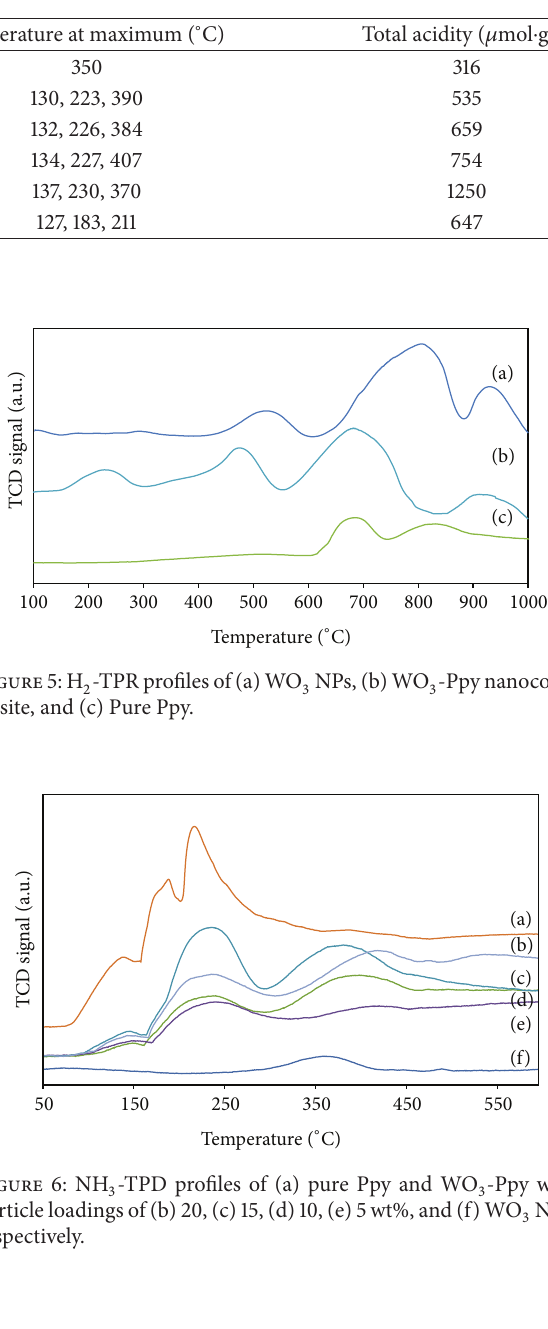
Table 1: Acidic properties of the samples obtained from TPD of ammonia.